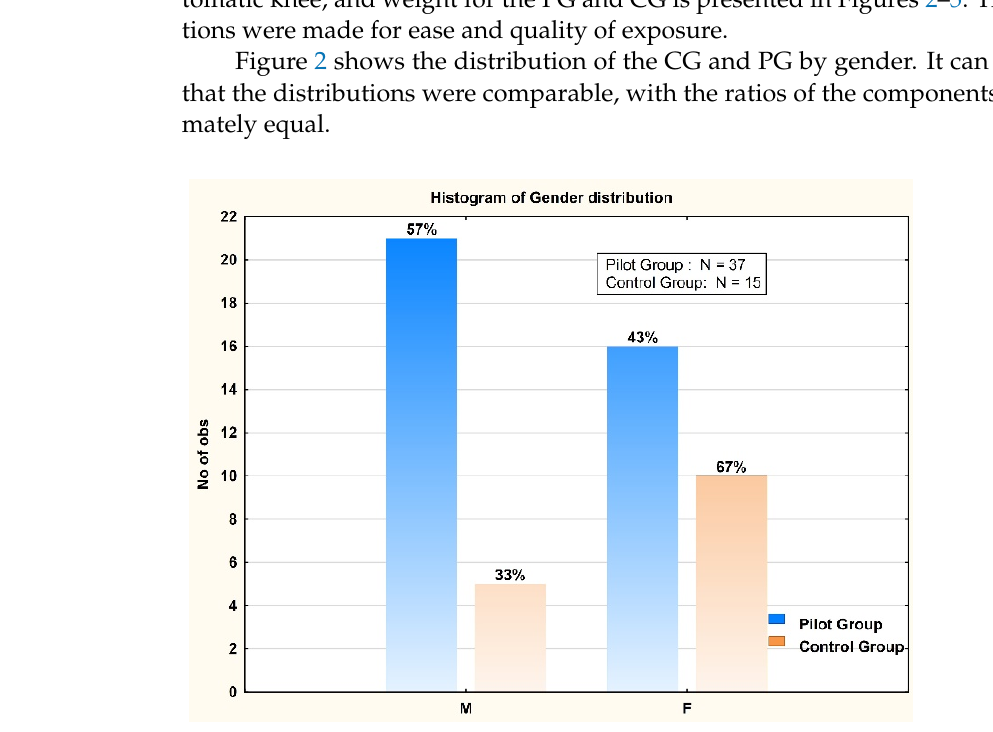
Figure 3. Histogram representation for the age interval distribution of the control group (CG) and the pilot group (PG). A t -test for the independent samples (i.e., the variables were treated as independent samples) showed that there were no differences between the age mean values, as is shown below (Table 2). Table 2. Characteristics of the t -test results. C.G. vs. P.G.